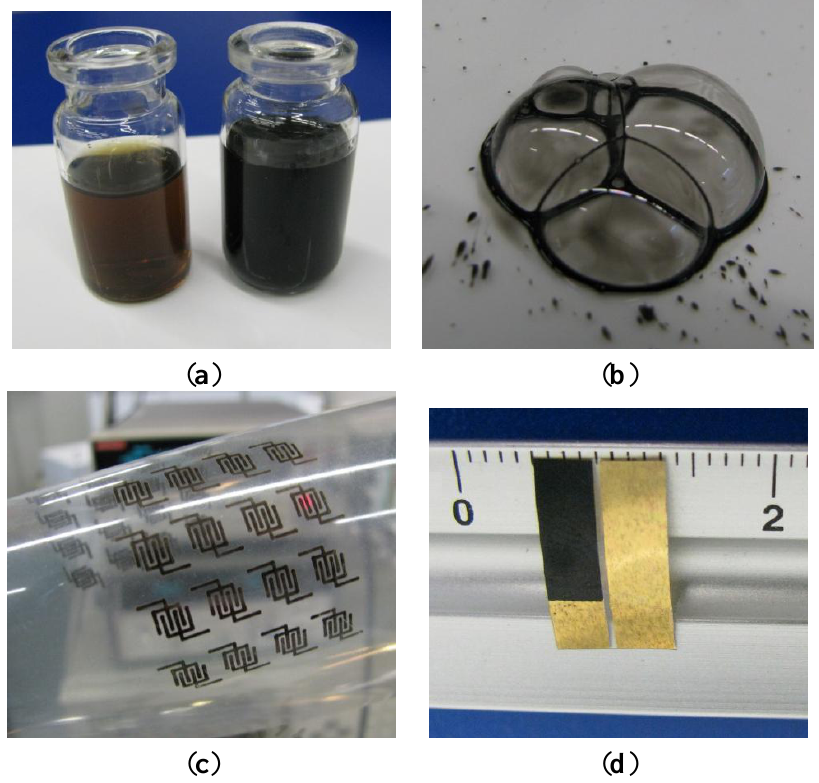
Figure 1. ( a ) Dark brown and black dispersions of Nafion:Cu and of